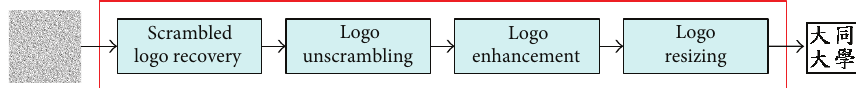
Figure 8: The four substages of logo restoration .